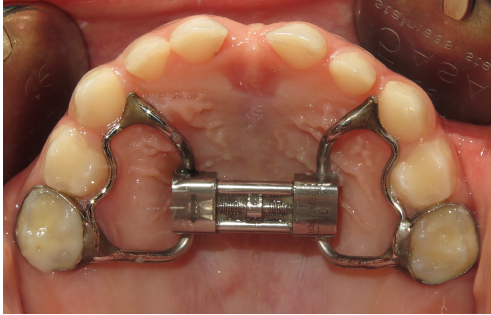
Figure 1. Customized rapid palatal expander